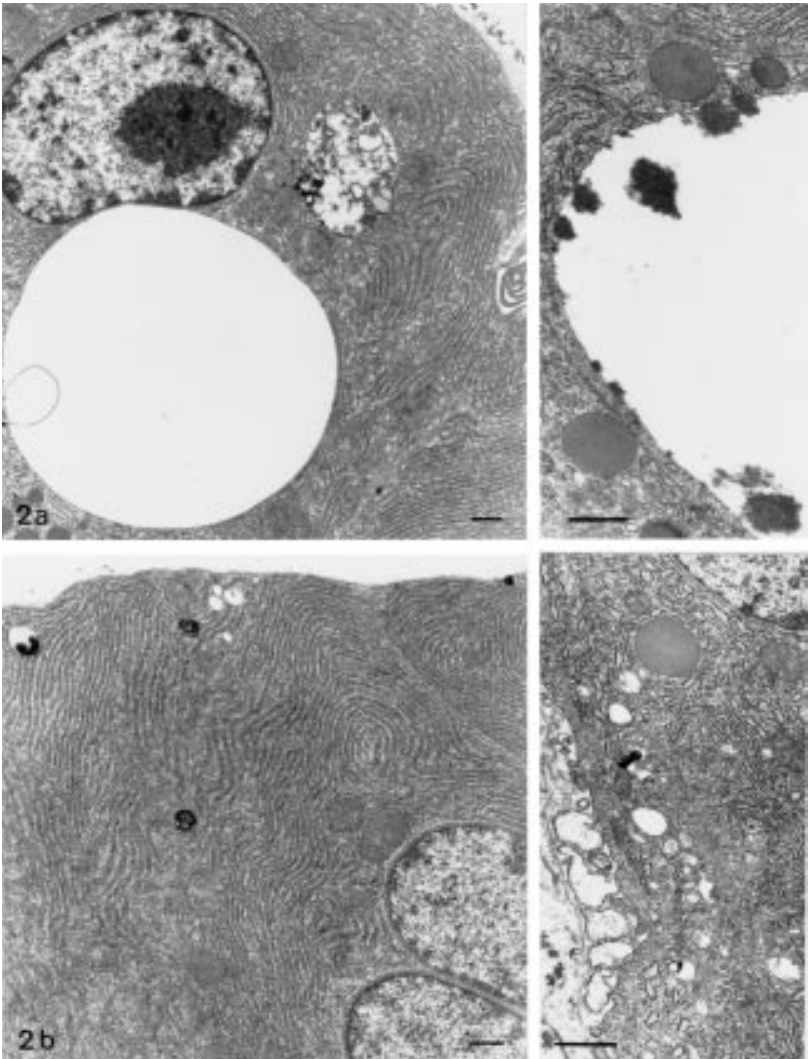
Fig. 2. (a) Rat pancreatic acinar cell 8 hours after cerulein application; electron microscopy; cell with a large rounded vacuole, containing an electron lucent contents (7000 (cid:2) ). Insert: border between the cytoplasm and the injury vacuole; some intact zymogen granules in the cytoplasm and numerous secreted granules in the vacuole, resolving by hydration (12000 (cid:2) ). (b) Rat pancreatic acinar cell 8 h after simultaneous cerulein and WGA administration; electron microscopy; cell without large injury vacuoles; a few small vesicles on the basal cell surface (7000 (cid:2) ). Insert: numerous small vesicles, presumably endocytic vesicles, on the basolateral border of the cell (12000 (cid:2)